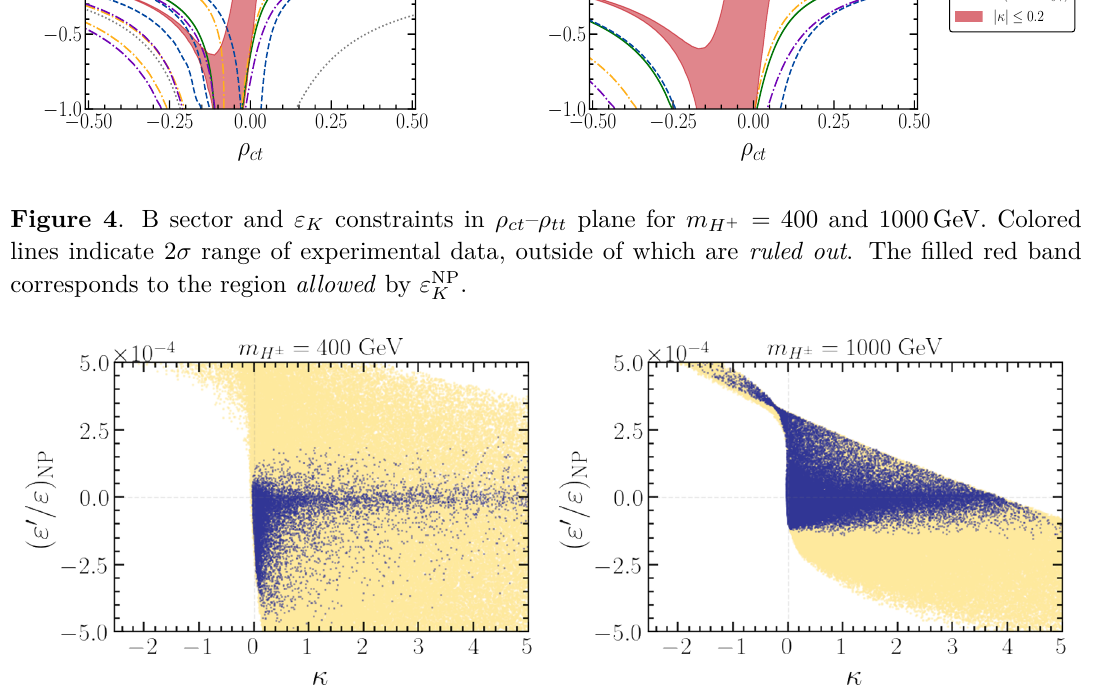
and ( ε 0 /ε ) NP from K